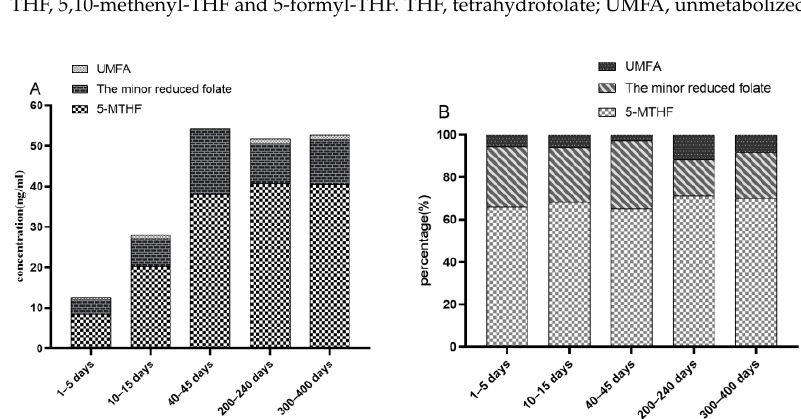
Figure 1. The concentrations of breast milk folate from 1 to 400 days postpartum ( A ). The distribution of folate species over 1–400 days postpartum ( B ). The minor reduced folate represents the sum of THF, 5,10-methenyl-THF and 5-formyl-THF; 5-MTHF, 5-methyltetrahydrofolate; UMFA unmetabolized folic acid.